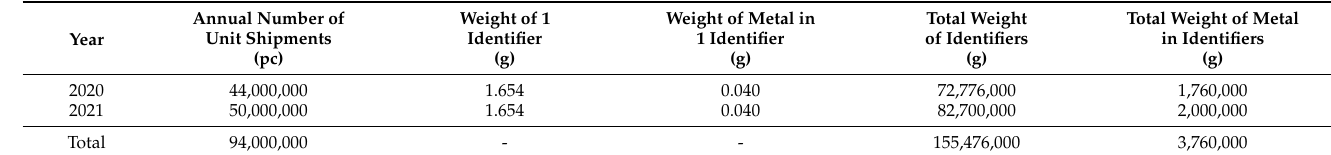
Table 4. Assumption of the annual weight of RFID tags generated by parcel delivery services company